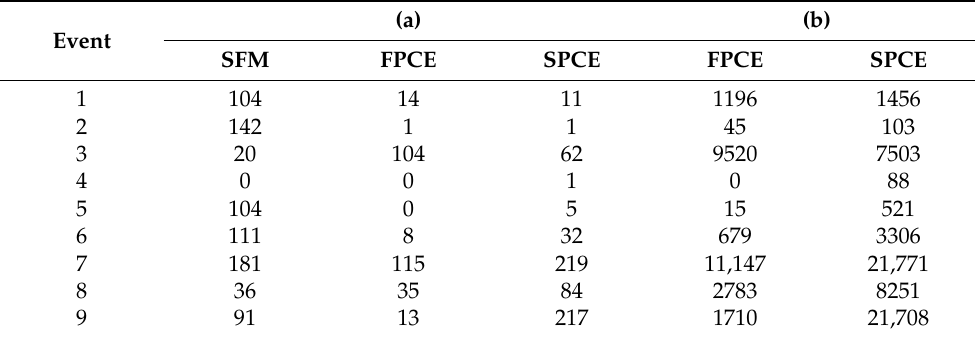
Table 4. The number of behavior runs obtained through GLUE for three models (SFM, FPCE, and SPCE), based on the likelihood function of NSE with its acceptance threshold of 0.8. Column ( a ) and column ( b ) present results obtained from 100,000 and 10,000,000 random runs, respectively. (a) (b) Event SFM FPCE SPCE